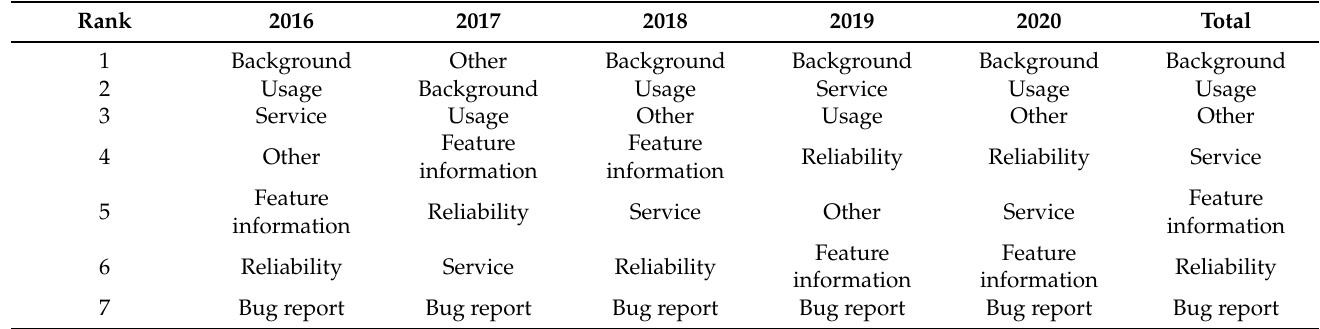
Table 5 is obtained by sorting the user satisfaction scores from 2016 to 2020. User satisfaction with the “Background” dimension and “Usage” dimension ranks high, while user satisfaction with the three dimensions of “Feature information”, “Reliability” and “Service” fluctuates somewhat, but is generally low. Table 5. Ranking Table of User satisfaction scores of Ping An Health App from 2016 to